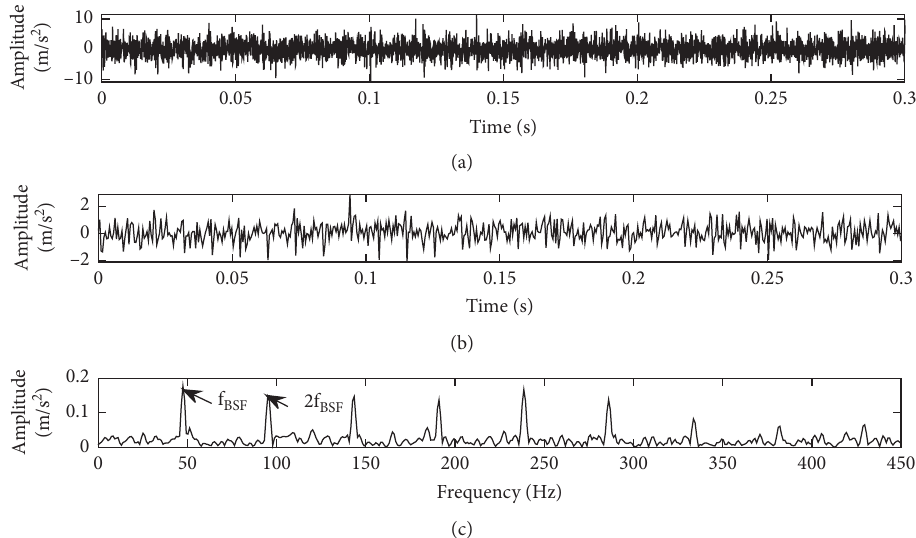
Figure 10: (a) The original simulation signal. (b) The signal filtered by fast computation of protrugram. (c) The square envelope for the filtered